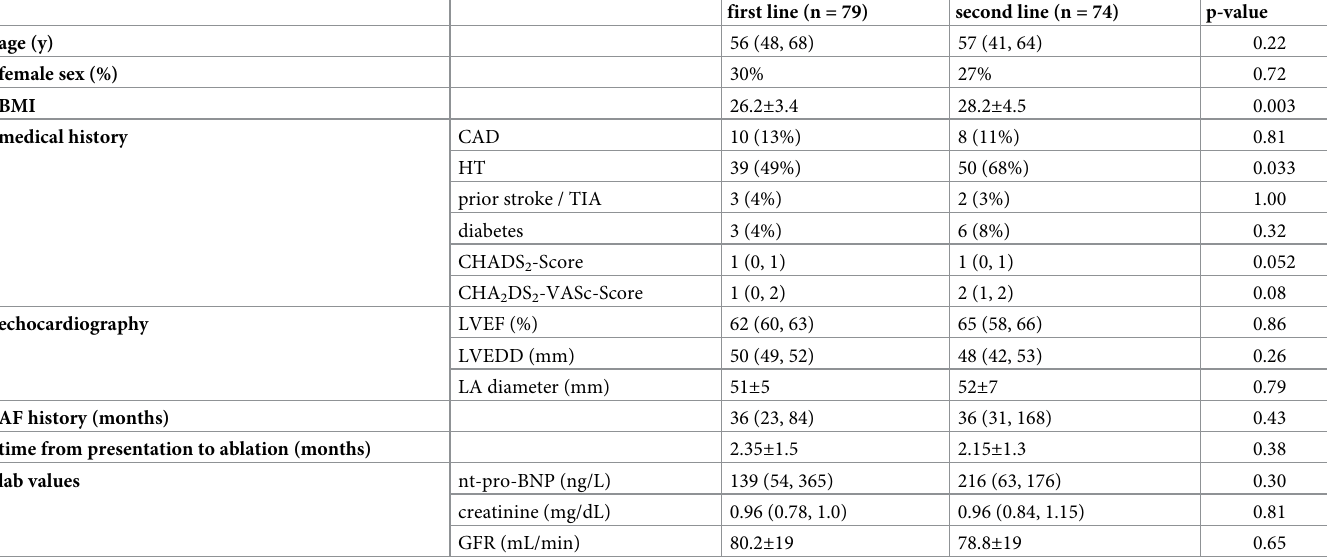
Table 1. Baseline characteristics of patients who underwent ablation as a first or second line therapy with inter-group comparison.